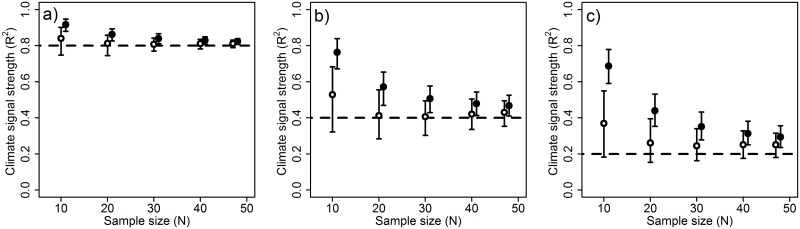
Performance of slidingwin in estimating the true R2 value of a climate signal.Performance determined at varying sample sizes with very high R2 (0.80; left), high R2 (0.40; centre), and moderate R2 (0.20; bottom) both without cross-validation (black) and with 10-fold cross-validation (white). Points represent median R2 estimates from 2,000 simulated datasets. Error bars represent inter-quartile range. The horizontal dashed line shows the true value of R2 used to generate the simulated datasets.